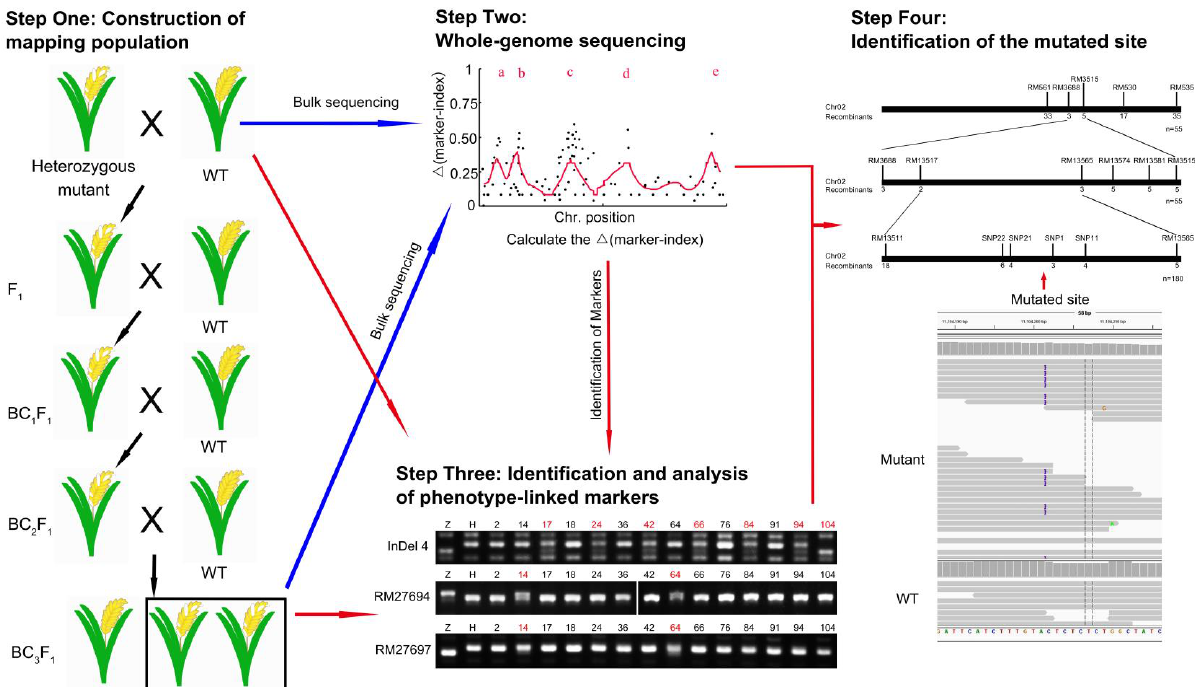
Figure 1. The simplified cloning scheme for the heterozygous mutant. Step One: the heterozygous mutant was crossed with WT of the other variety four times to generate the BC 3 F 1 population. Step Two: about 30–200 heterozygous plants of BC 3 F 1 population were selected to extract DNA, and the DNA samples were mixed with equimolar of each, resequenced, and analyzed. The markers (mainly SNP and InDel) were identified and their marker indexes were calculated to identify the high-quality markers for identifying the candidate regions using the MutMap method. Step Three: the BC 3 F 1 population was used for the analysis of the recombinants at the phenotype-linked markers to identify and narrow the candidate region with the markers which were downloaded from the sharing platform on the internet or identified from the resequencing results. Step Four: using the resequencing genome data, the mutational sites (the ∆ marker-index was about 0.5) in the target region were